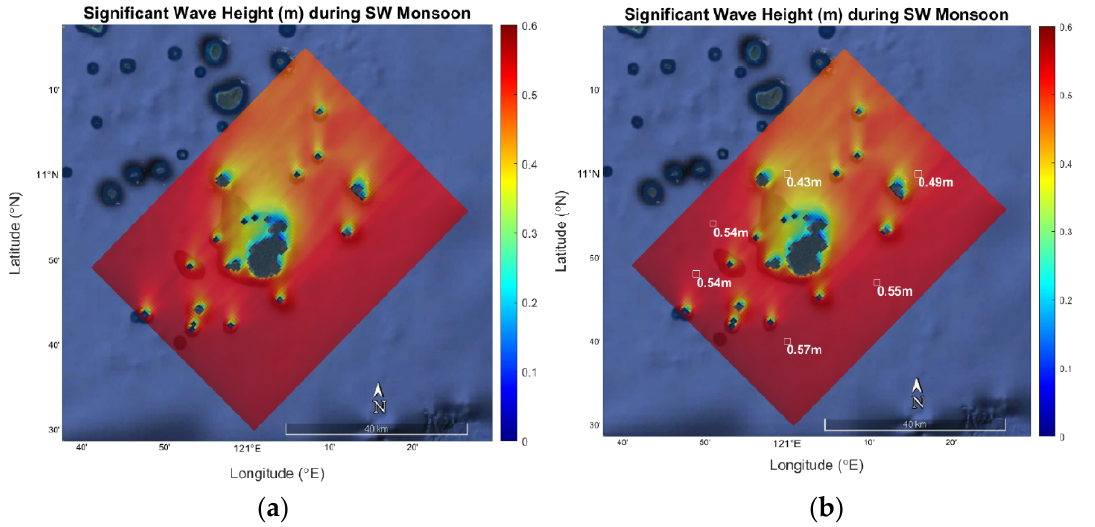
Figure 19. ( a ) H s (m) model during southwest monsoon season and ( b ) H s model indicating the average H s at stations A–F.